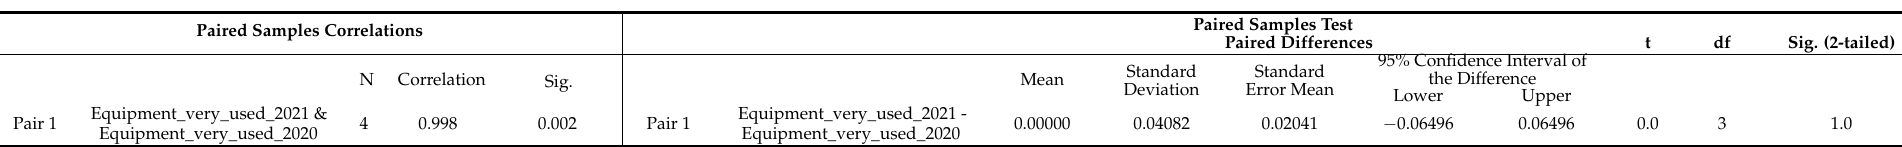
Table 27. Paired samples t-test applied for the perspective of students in two different academic years on most preferred hardware equipment for online classes. Paired Samples Correlations